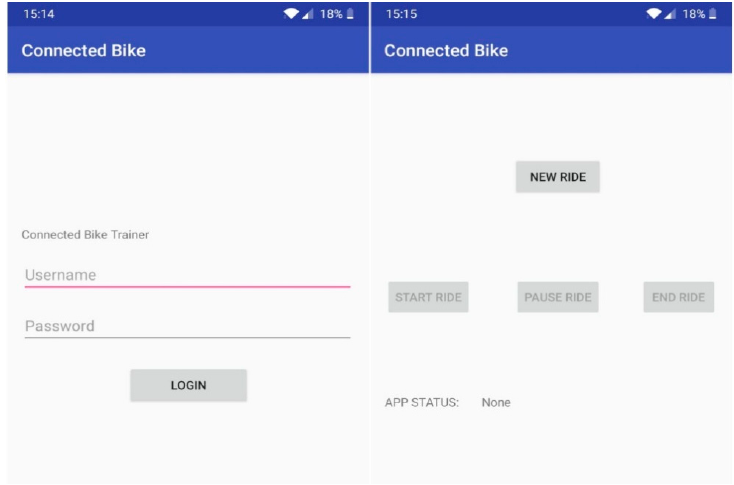
Figure 18. Android application interface